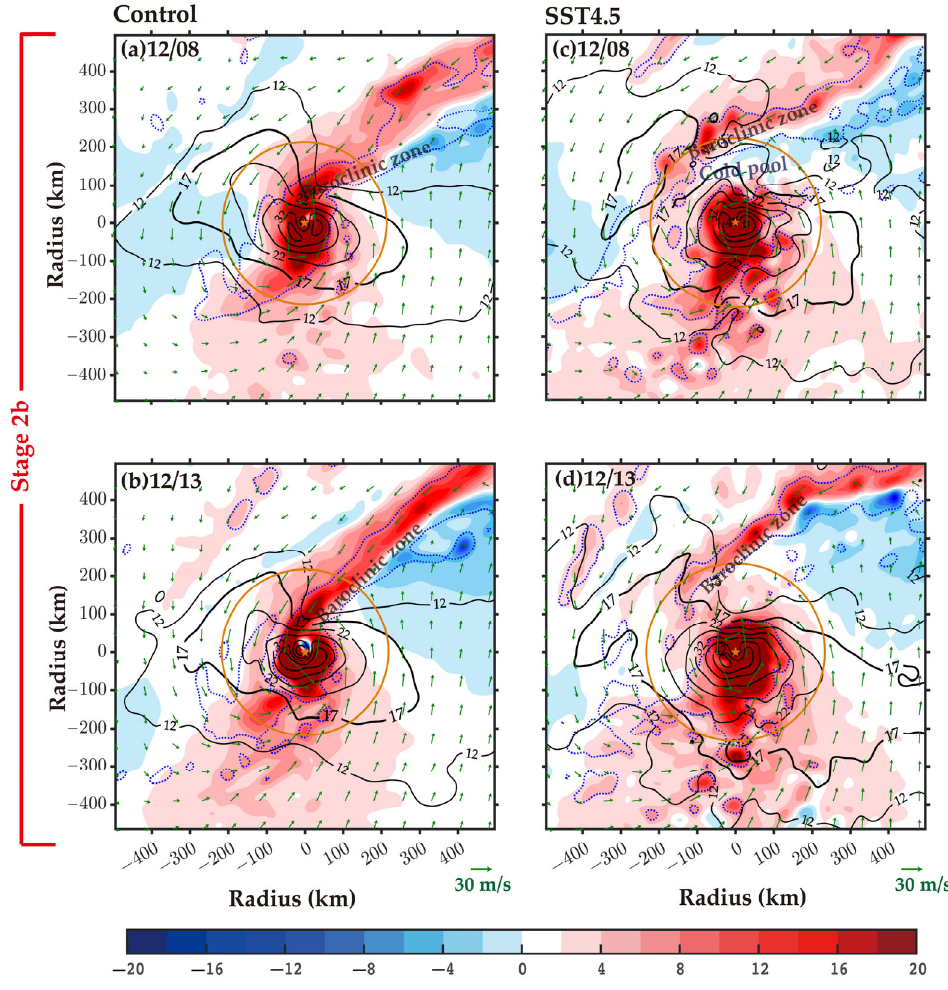
Figure 11. As in Figure 9 but for 12/08 and 12/13 (stage 2b).